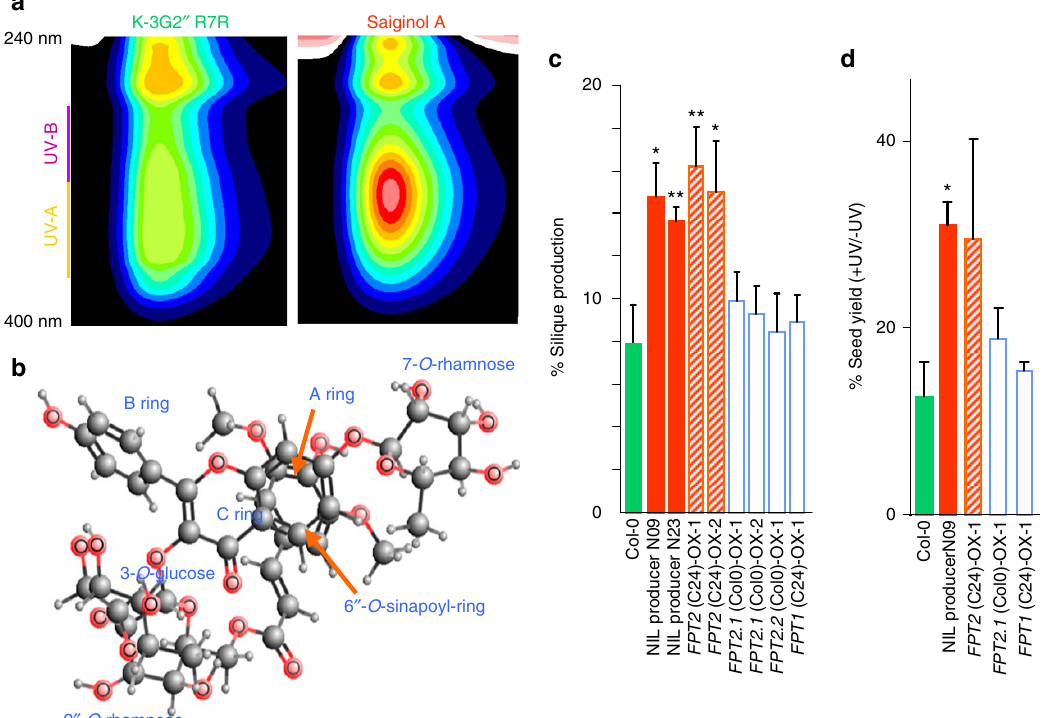
Figure 4 | Functional characterization of the role of saiginols and FPT2 in protection against UV-B irradiation. ( a ) UV absorbance shift of flavonol by phenylacylation measured by HPLC-PDA. Purified compounds, a precursor (K-3G2 00 R7R) and saiginol A were used for the profile. ( b ) Computational estimation of the most stable stereochemical structure performed by MMFF94 of Marvin (http://www.chemaxon.com/). ( c ) Rate of silique production under UV-B irradiation after long-term (2h per day) UV-B treatment (1Wm (cid:2) 2 ) using the detached immature inflorescences of first bolting. Error bars indicate the s.e. of six biological replicates. ( d ) Seed yield after long-term (2h per day for 28 days, 2Wm (cid:2) 2 ) UV-B treatment using 3-week-old intact plants. Seeds were collected on a single plant basis but three individual plants per genotype were measured. Data are presented as mean ± s.e.m. * P o 0.05, ** P o